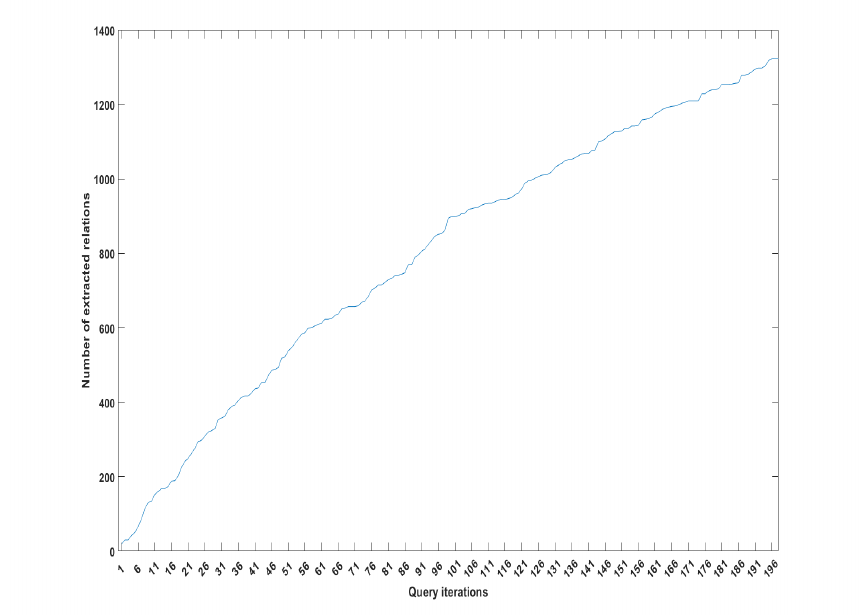
Figure 3. How the knowledge base (KB) increase with continuous learning. The vertical axis (y-axis) shows the number of facts FACT has learn. The horizontal axis (x-axis) shows the number of